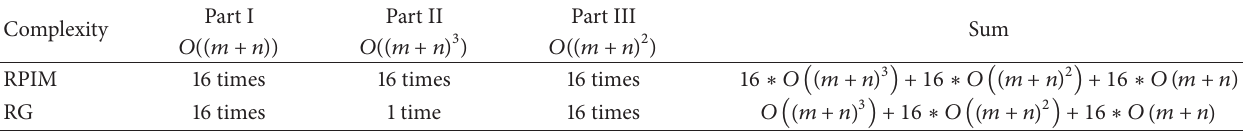
Table 6: The complexity of the integration for a Gauss domain.